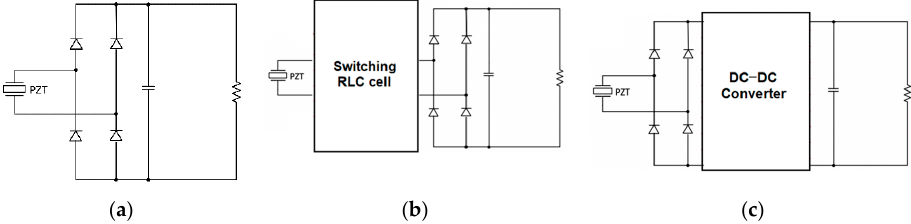
Figure 1. Conditioning circuits for piezoelectric energy harvesting based on ( a ) a full-wave diode rectifier, ( b ) a resonant rectifier, and ( c ) an active rectifier.